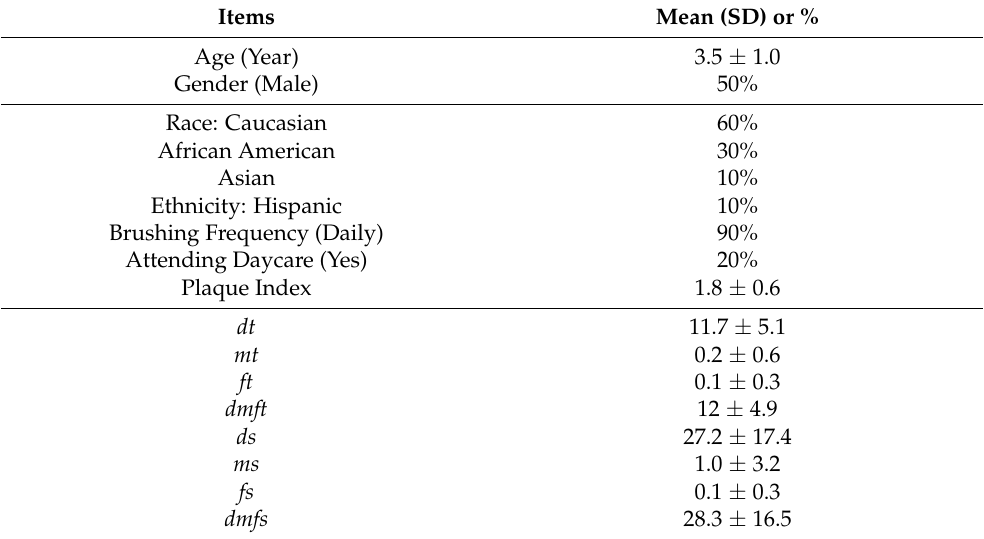
Table 1. Demographics data and characteristics of study participants (n =